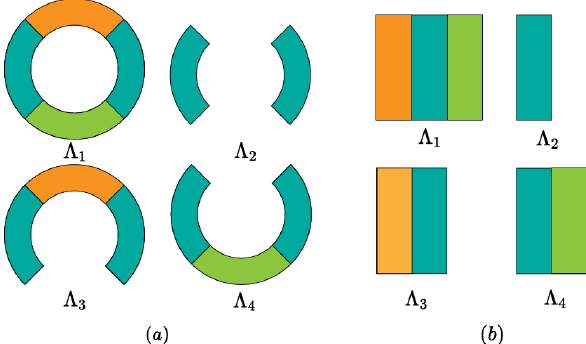
Figure 6: Pictorial representation of genuine topological difference. Consider the sets Λ , Λ , Λ and Λ sketched in both ( a ) and ( b ) . In both ( a ) and ( b ) the sets E Λ Λ 1 2 3 4 1 2 = E and E Λ are equal E Λ . While ( a ) the sets show genuine topological Λ Λ Λ Λ 1 2 1 2 3 4 (cid:54)∼ E ) − n ( E ) = 2; ( b ) the sets do not difference E Λ , because n ∂ ( E Λ Λ Λ Λ Λ ∂ Λ Λ 1 2 3 4 1 2 3 4 ∼ E ) − n ( E ) = have any topological difference E Λ , indeed n ∂ ( E Λ Λ Λ Λ Λ ∂ Λ Λ 1 2 3 4 1 2 3 4